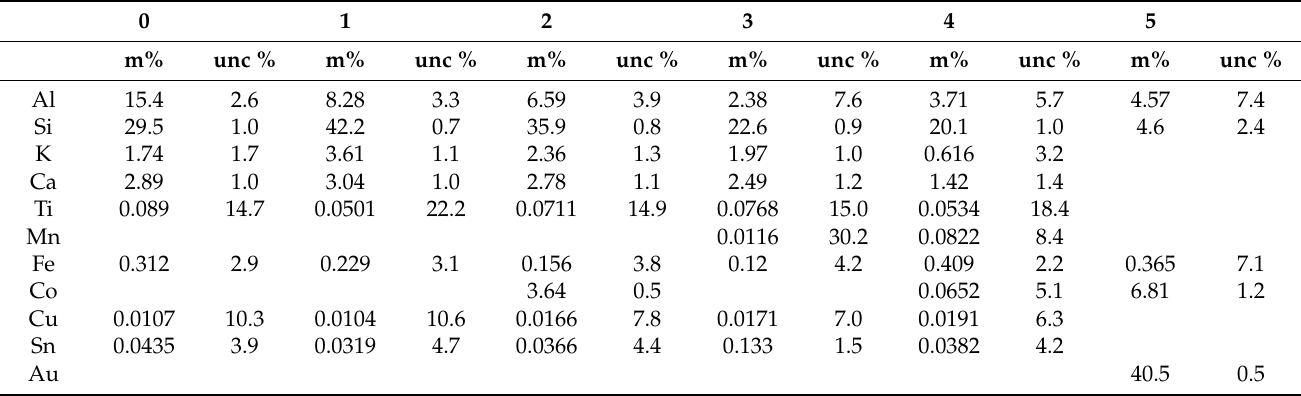
Table 2. Mass percentage (m%) concentrations by pXRF at measurement spots shown in Figure 3a, together with their 1-sigma relative uncertainties.